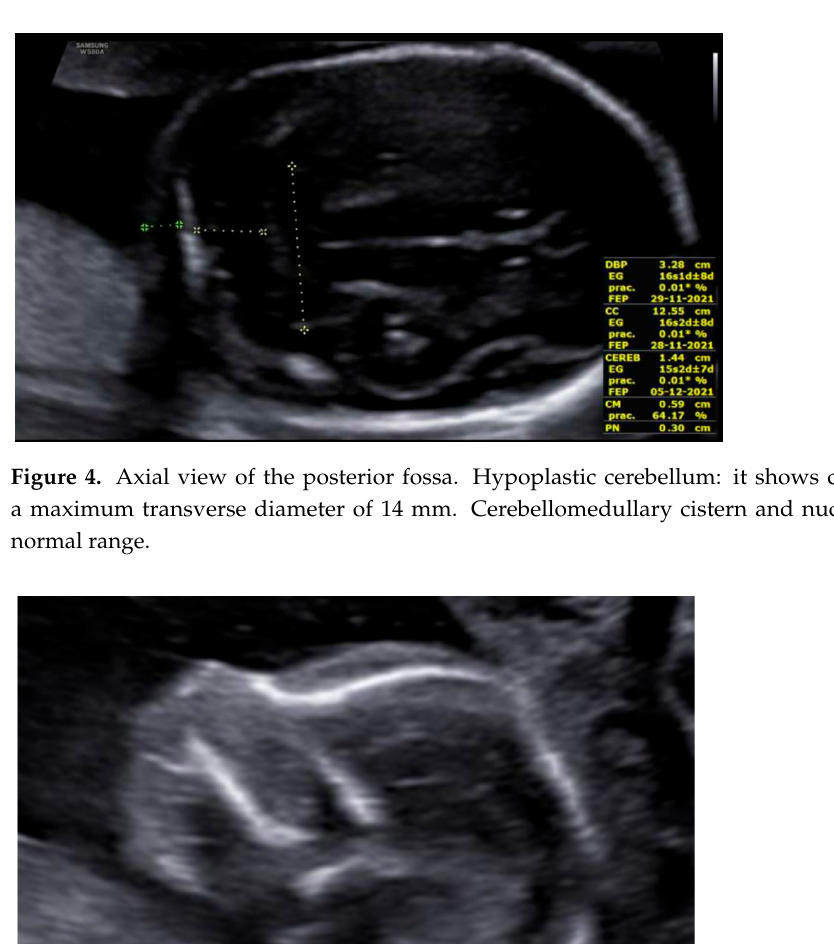
Figure 4. Axial view of the posterior fossa. Hypoplastic cerebellum: it shows cerebellum with a maximum transverse diameter of 14 mm. Cerebellomedullary cistern and nuchal fold within normal range.